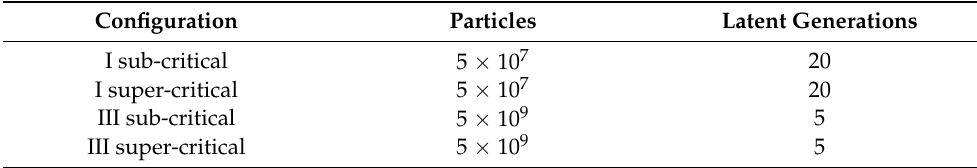
Table 3. Numerical simulation parameters for benchmark configurations: adjoint simulations.